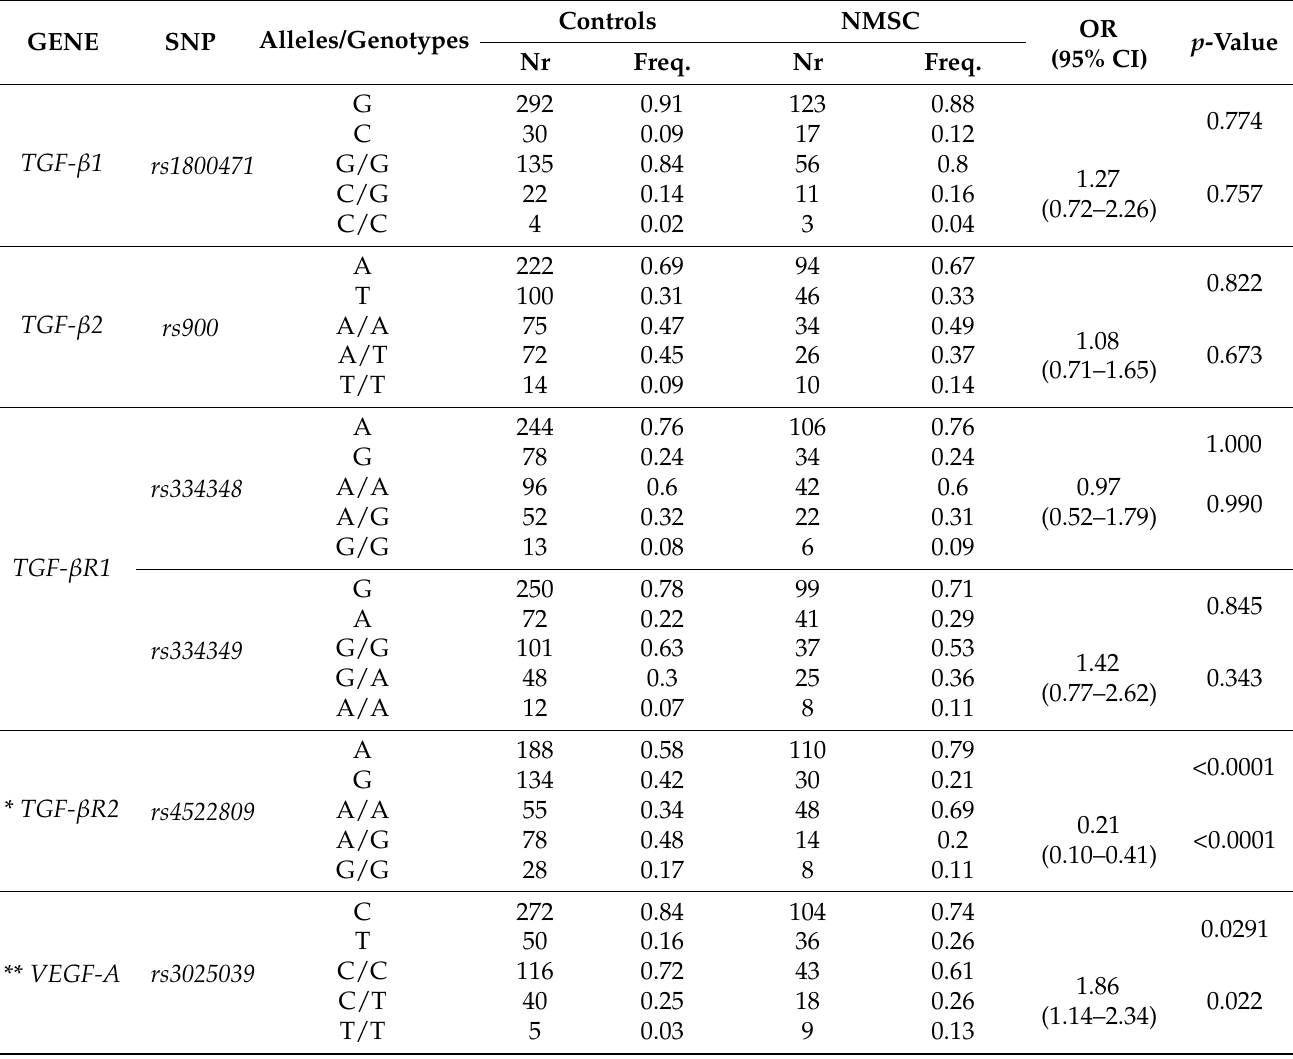
Table 3. Significantly different allelic and genotypic SNP frequencies in 70 non-melanocitic skin cancer patients (NMSC) and 161 control